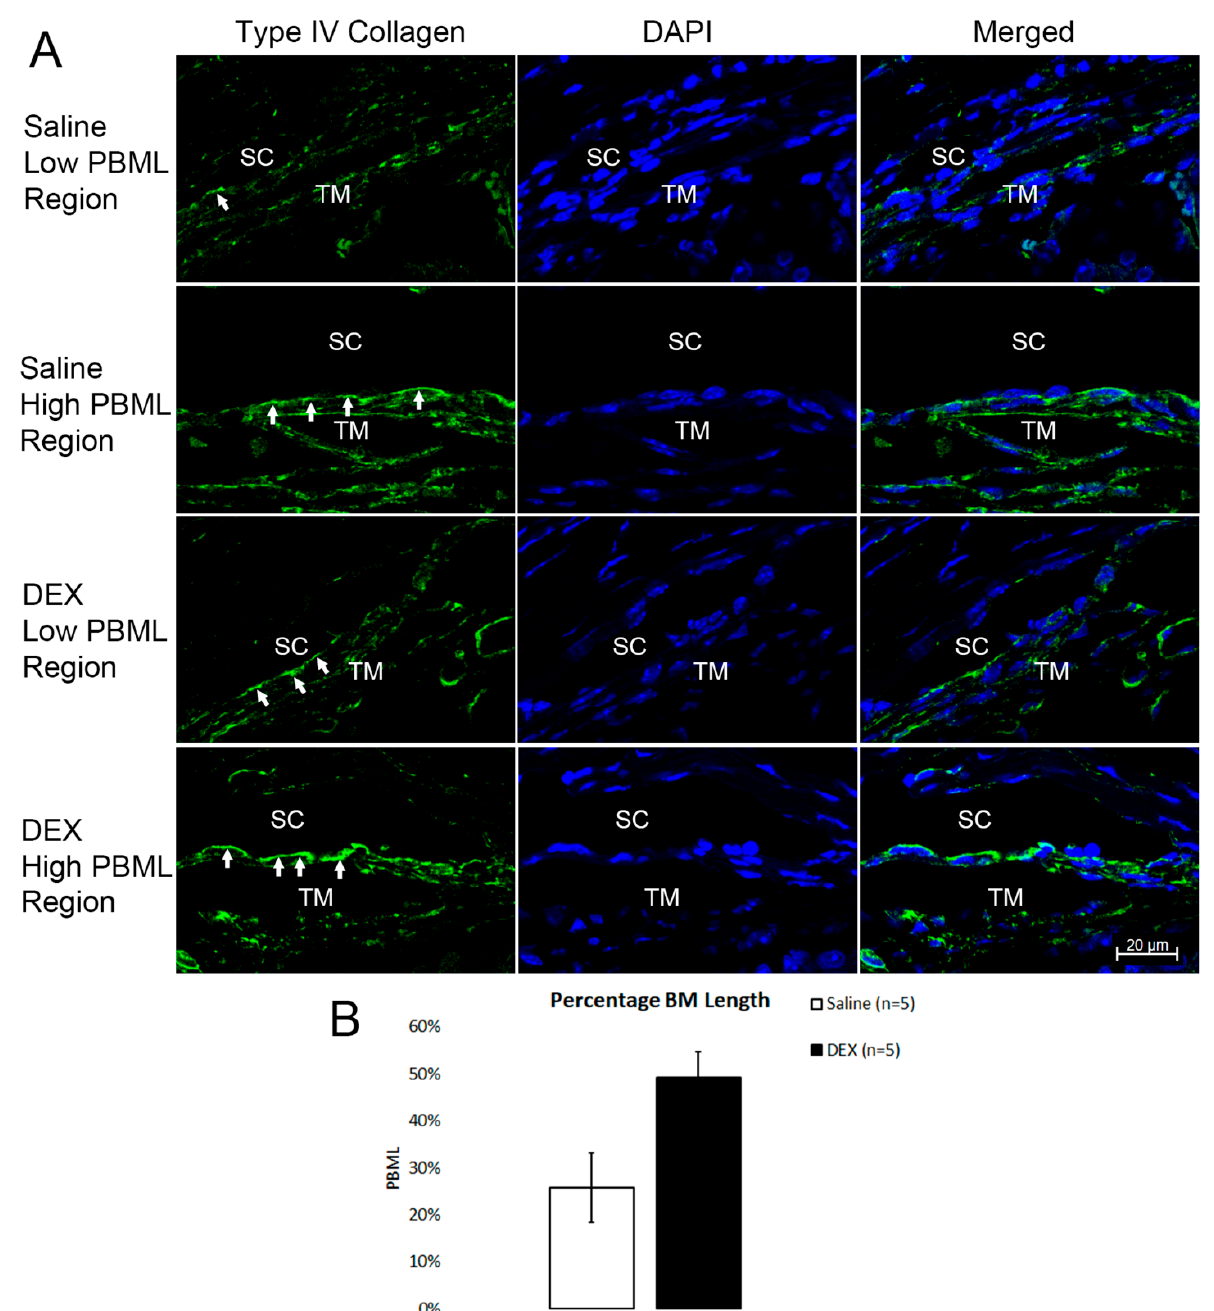
Figure 7. Increased PBML after DEX treatment by Immunohistochemistry. ( A ) Representative confocal images show that percentage basement membrane length (PBML) varies in both dexamethasone (DEX)-treated and untreated eyes. The green represents positive staining of type IV collagen, a major component of BM in the trabecular meshwork (TM), while the blue represents nuclei. The white arrows indicate the BM of the inner wall of Schlemm’s canal (SC). ( B ) Mean PBML was higher in DEX-treated eyes when compared to controls, indicating that BM became more continuous after DEX-treatment. However, this difference did not quite reach statistical significance ( p = 0.06).